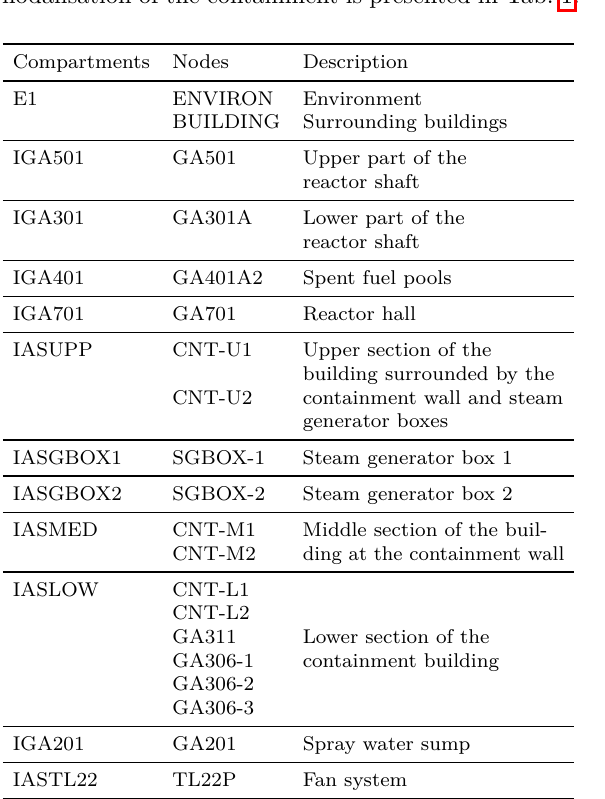
Table 1. Containment discretization.